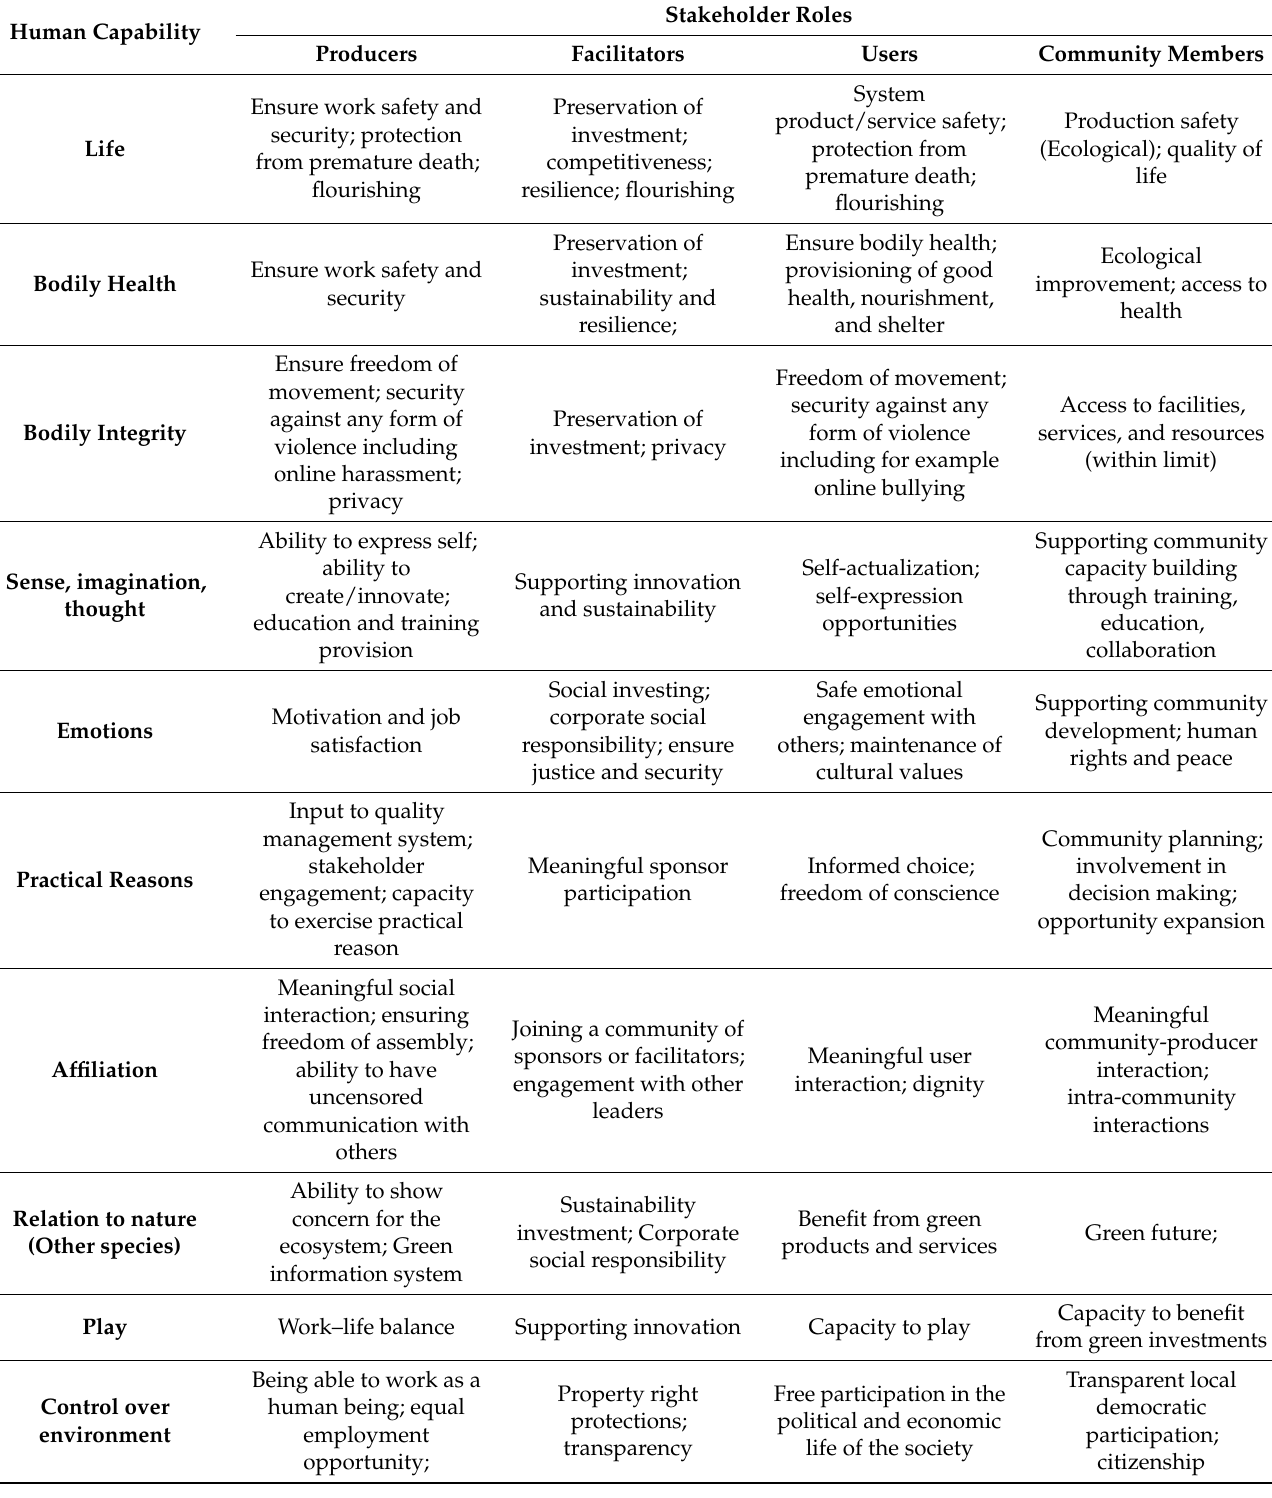
Table 3. Mapping the co-creation of EA stakeholder capabilities (adapted from